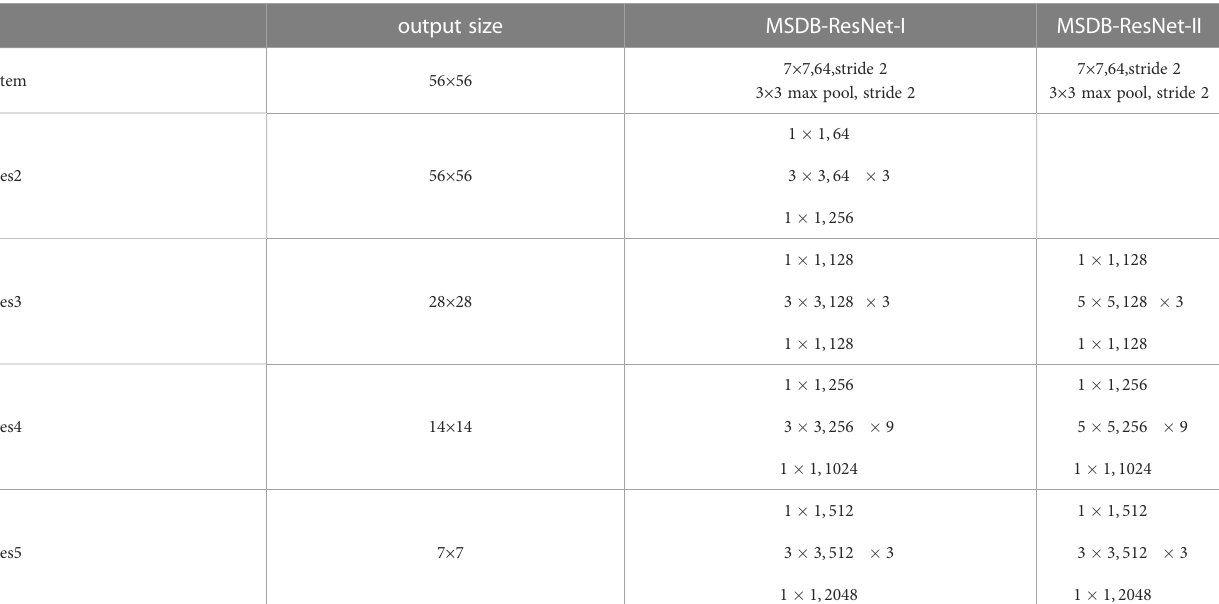
TABLE 2 Model compute